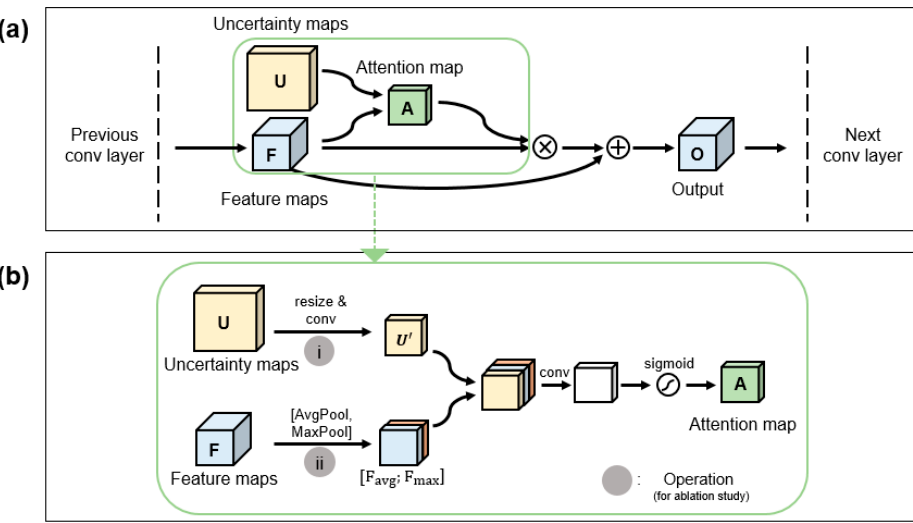
Figure 3. Architecture of uncertainty attention module (UAM). This subnetwork module can effectively exploit uncertainty maps by applying an attention mechanism. This module is plugged into any neural network. This architecture, including the operations, was highly optimized by an ablation study. Conv = convolution; AvgPool = average pooling; MaxPool = max pooling; F avg = feature maps from average pooling operation; F max = feature maps from max pooling operation. ( a ) UAM architecture overview. ( b ) Specific architecture of green box